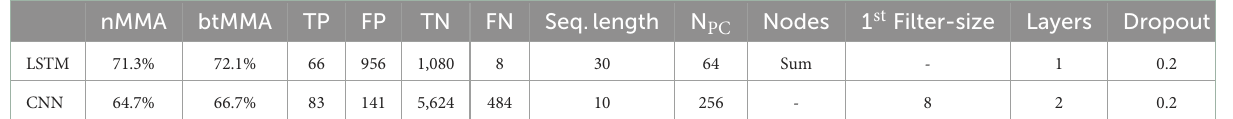
TABLE 7 Performance metrics for the final LSTM and CNN